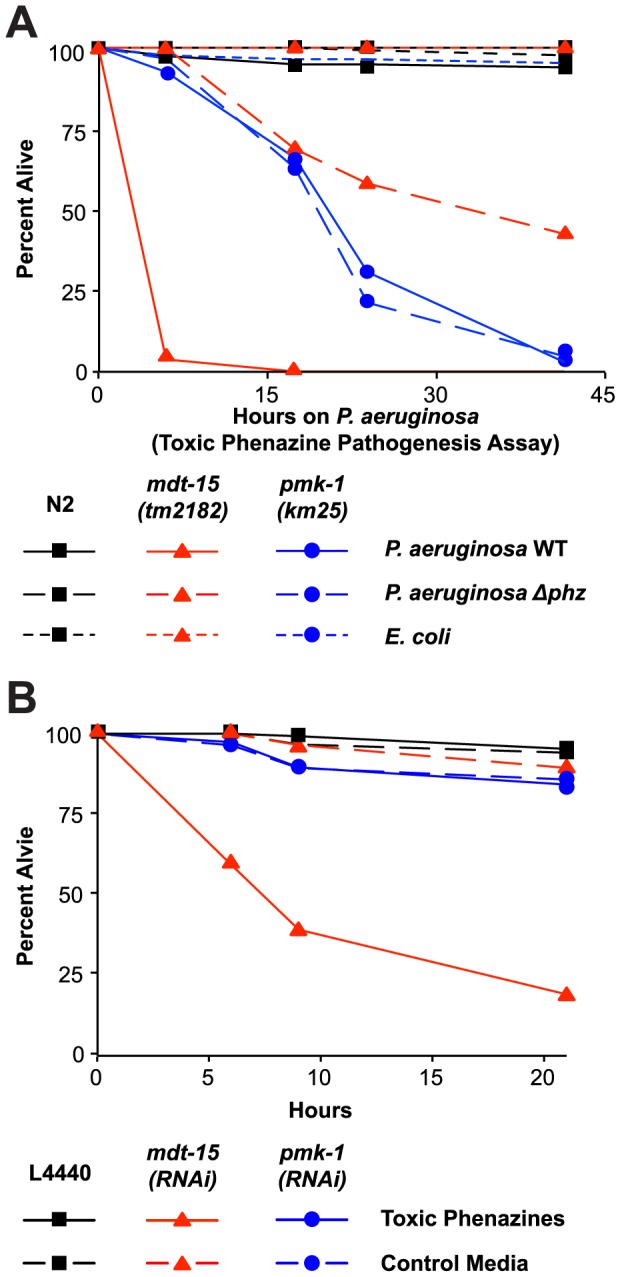
Resistance to P. aeruginosa phenazine toxins requires MDT-15.(A) Wild-type N2, mdt-15(tm2182) and pmk-1(km25) animals were tested in the toxic phenazine P. aeruginosa pathogenesis assay (also called “fast killing” assay). C. elegans young adult animals were exposed to wild-type (WT) P. aeruginosa, P. aeruginosa carrying a deletion in both of the phenazine biosynthetic operons (Δphz) or E. coli OP50. The difference between mdt-15(tm2182) and N2 animals exposed to P. aeruginosa WT is significant (p<0.001), as is the difference in mdt-15(tm2182) animals exposed to P. aeruginosa WT and P. aeruginosa Δphz (p<0.001). There is no significant difference in pmk-1(km25) animals exposed to P. aeruginosa WT and P. aeruginosa Δphz (p>0.05). This assay is representative of two independent experiments. Figure S6A presents the control condition for this experiment showing that both C. elegans N2 and mdt-15(tm2182) at the L4 stage are sensitive to toxic phenazine-mediated killing (p<0.001). (B) Vector control (L4440), mdt-15(RNAi) and pmk-1(RNAi) animals were exposed to high osmolarity “fast kill” media (pH 5) with E. coli as the food source in the presence or absence of phenazine-1-carboxylic acid and 1-hydroxyphenazine (labeled “toxic phenazines” above) at the approximate concentrations produced by P. aeruginosa under standard assay conditions. The difference in killing between mdt-15(RNAi) animals exposed to toxic phenazines and the other conditions is significant (p<0.001). See also Figure S6. For sample sizes, see Table S3.